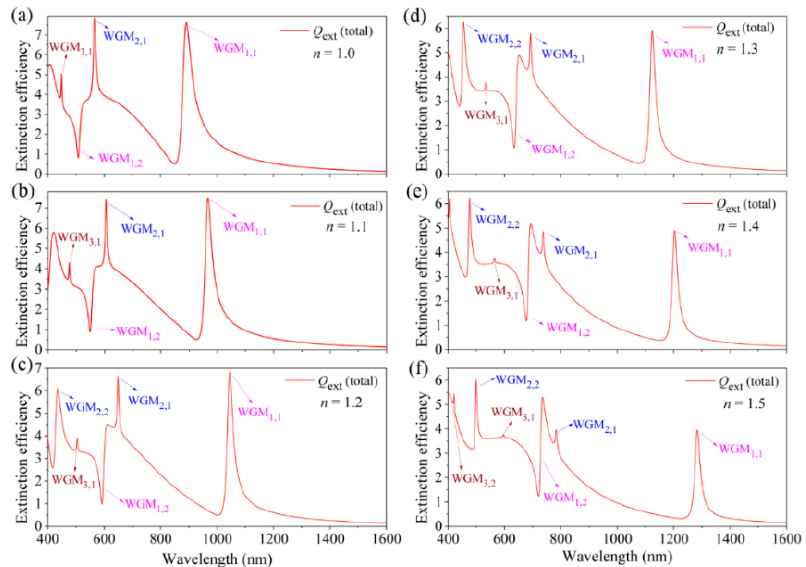
Figure 5. ( a – f ) The calculated total extinction efficiency spectra of the spherical HMM cavity for different n from 1.0 to 1.5, respectively. Other structural/materials parameters: r = 20 nm, s = 20 nm and d = 15 nm.